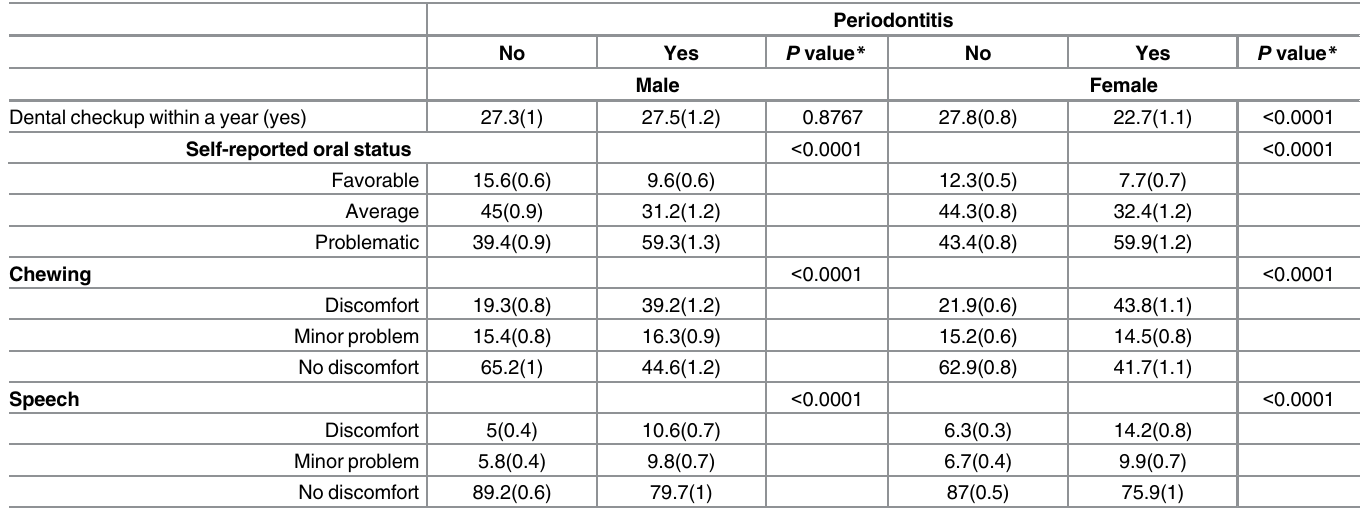
1.299(1.007 – 1.676), and 1.458(1.141 – 1.862) for once per month or less, once per month < x (cid:1) 3 times per week, three times per week < x (cid:1) 6 times per week, once per day, twice per day, and three or more per day, respectively ( P for trend < 0.05). Adjusted odds ratios and their 95% confidence intervals of the female participants were 1, 1.154(0.862 – 1.545), 0.951(0.750 – 1.205), 0.941(0.771 – 1.148), 1.034(0.825 – 1.296), and 1.265(0.969 – 1.65) for once per month or less, once per month < x (cid:1) 3 times per week, three times per week < x (cid:1) 6 times per week, once per day, twice per day, and three or more per day, respectively ( P for trend > 0.05). The